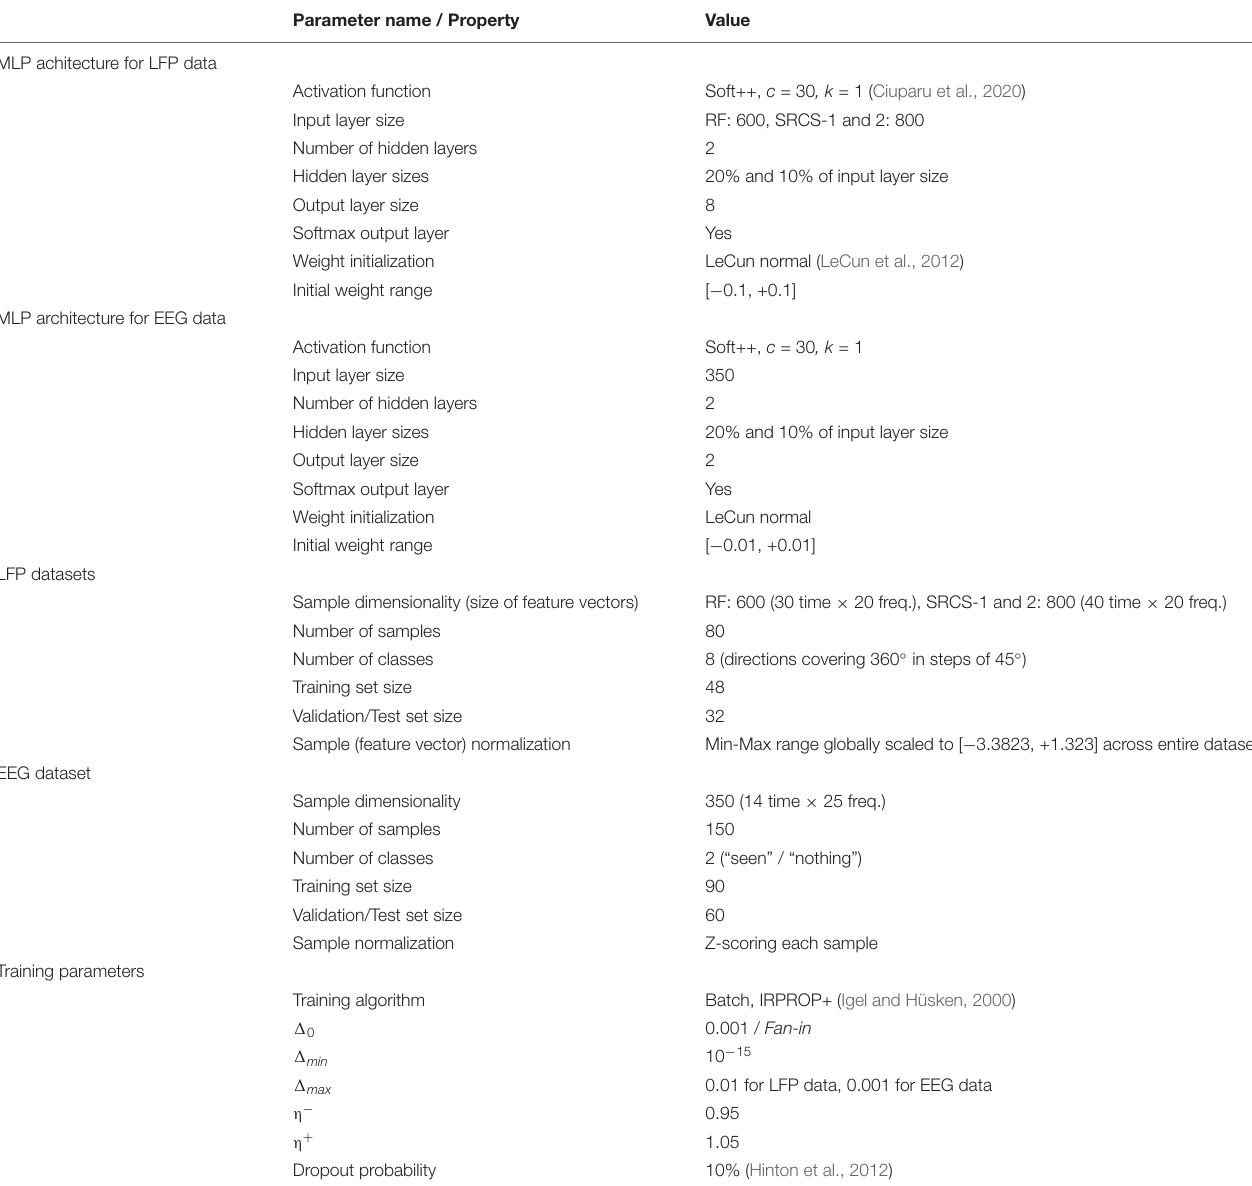
TABLE 1 | Architecture of MLP networks, properties of datasets, and parameters of the training